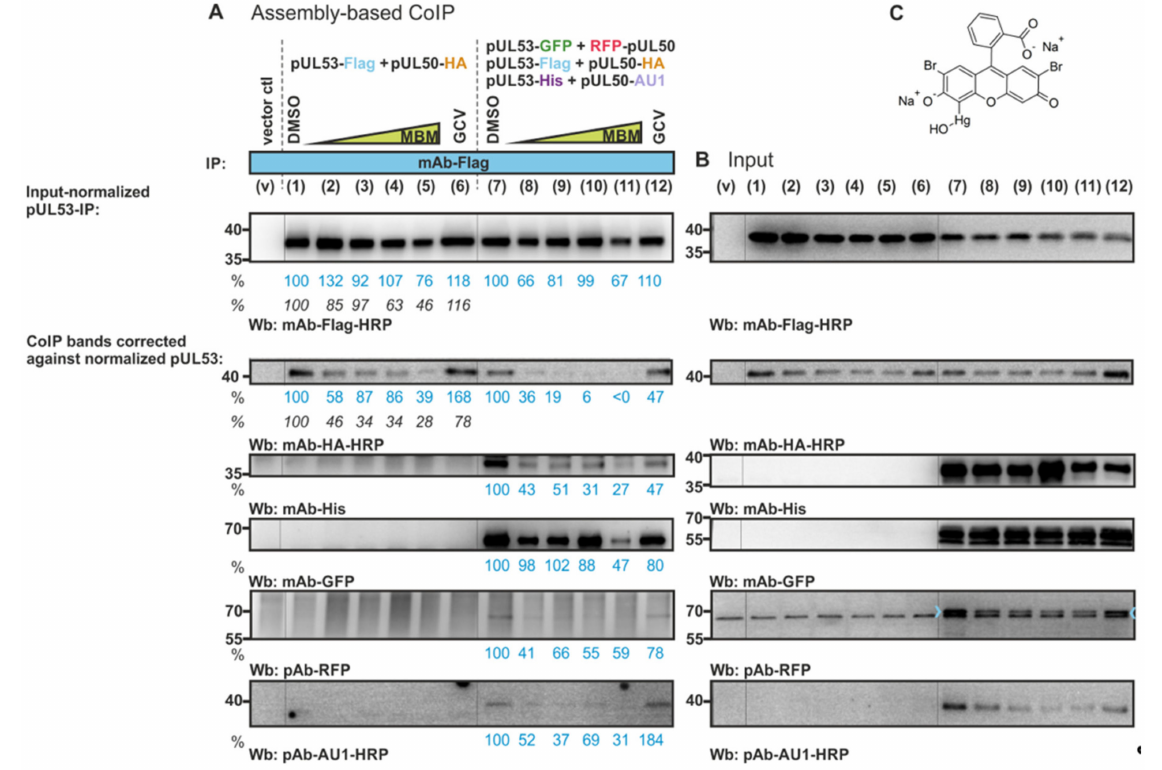
Figure 7. Analysis of the sensitivity of the HCMV core NEC oligomeric assembly towards a small molecule NEC inhibitor. ( A ) An in vitro NEC assembly assay was performed in the presence of increasing concentrations of the newly identified small molecule NEC inhibitor merbromin ([30]; MBM 1.25, 2.5, 5 and 10 µ M; 0 µ M/DMSO control). The indicated expression plasmids were used for the single transient transfection of 293T cells and harvested at approx. 2 d p.t. for the preparation of total lysates. Combinations of these samples were used in twofold or sixfold settings of in vitro assembly as indicated above the immunoblots (left panels: v, vector control; 1–12, combinations of in vitro assembly reactions; incubated at 4 ◦ C overnight under rotation). Optionally, in vitro assembly reactions were performed in the presence of MBM (panels 2–5 and 8–11; 1.25–10 µ M), DMSO as a solvent control (panels 1 and 7) or ganciclovir as an antiviral reference drug (GCV, 10 µ M; panels 6 and 12). Thereafter, the assembled complexes were subjected to CoIP, using the indicated immunoprecipitation antibodies (IP), and subsequently analyzed in a standard SDS-PAGE/Wb procedure, using the indicated antibodies for immunostaining (Wb). Note in panels 1–6, the MBM-mediated reduction of pUL50-HA assembly (lowest Wb panel), which was not obtained with GCV. Note in panels 7–12, the MBM-mediated reduction of the assembly of His-, GFP-, RFP-, AU1- and HA-tagged versions of the NEC proteins (while pUL53-Flag, as the direct IP target of mAb-Flag, remained mostly unaffected). The GCV control showed either no or only modest reducing activity compared to DMSO. Quantitation of the band intensities was performed by densitometry (AIDA Image Analyzer v.4.23 software). All determinations were done in duplicate and the mean values of CoIP signals were at first corrected against the individual input levels (i.e., the DMSO controls were taken as reference bands and variations of protein input levels were calculated as correction factors that were then applied to adjust the corresponding values of CoIP bands). The second step of normalization was then performed through a correction factor that compensated the partly varying amounts of immunoprecipitated pUL53 (mAb-Flag-HRP) so that percentages referring to the DMSO control are given. For lanes 1–6, an independent replicate of this experiment (primary data not shown) was likewise evaluated as indicated by the additional values in italics. ( B ) Expression levels of the individual proteins were monitored by the detection of lysate controls on Western blots (right panels: v, vector control; 1–12, single-expression protein samples, subsequently taken as the input for in vitro assembly reactions). ( C ) Chemical structure of merbromin